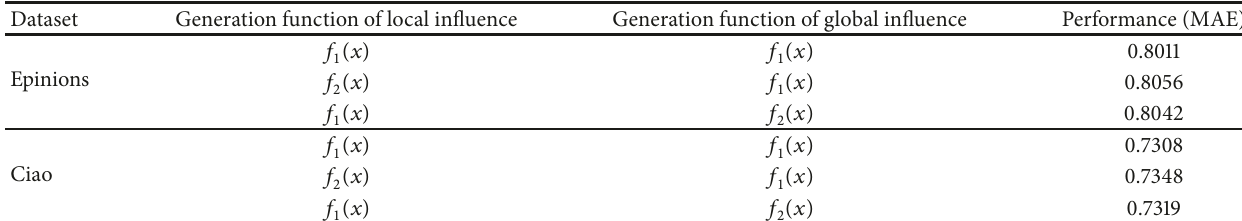
Figure 4: Performance comparisons of cold-start users (dimensionality=20). Table 5: Performance comparisons using different generation